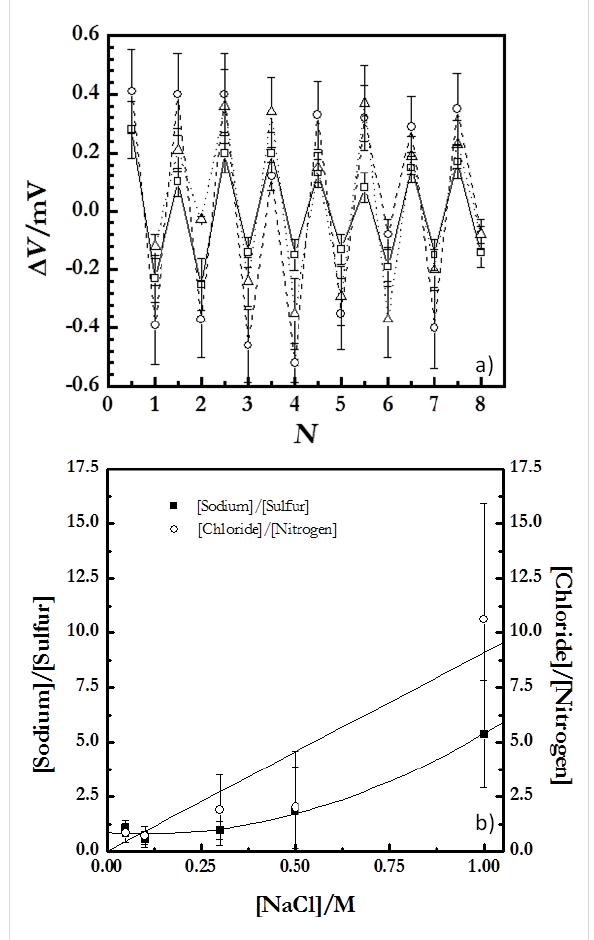
Figure 8: (a) Changes in the surface potential, Δ V , as a function of N for (PDADMAC + PSS) N films formed at different ionic strengths. The different symbols represent different ionic strengths: (open squares) 0 M, (open circles) 0.05 M, (open triangles) 1.00 M. (b) Ratios of [sodium]/[sulfur] and [chloride]/[nitrogen] as a function of the ionic strength obtained for dry multilayers from XPS spectra. The lines are to guide the